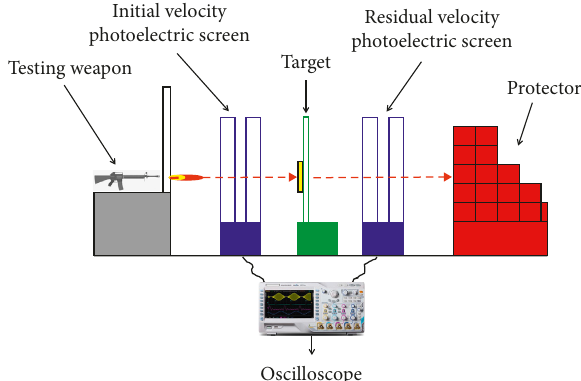
Figure 2: Schematic diagram of ballistic